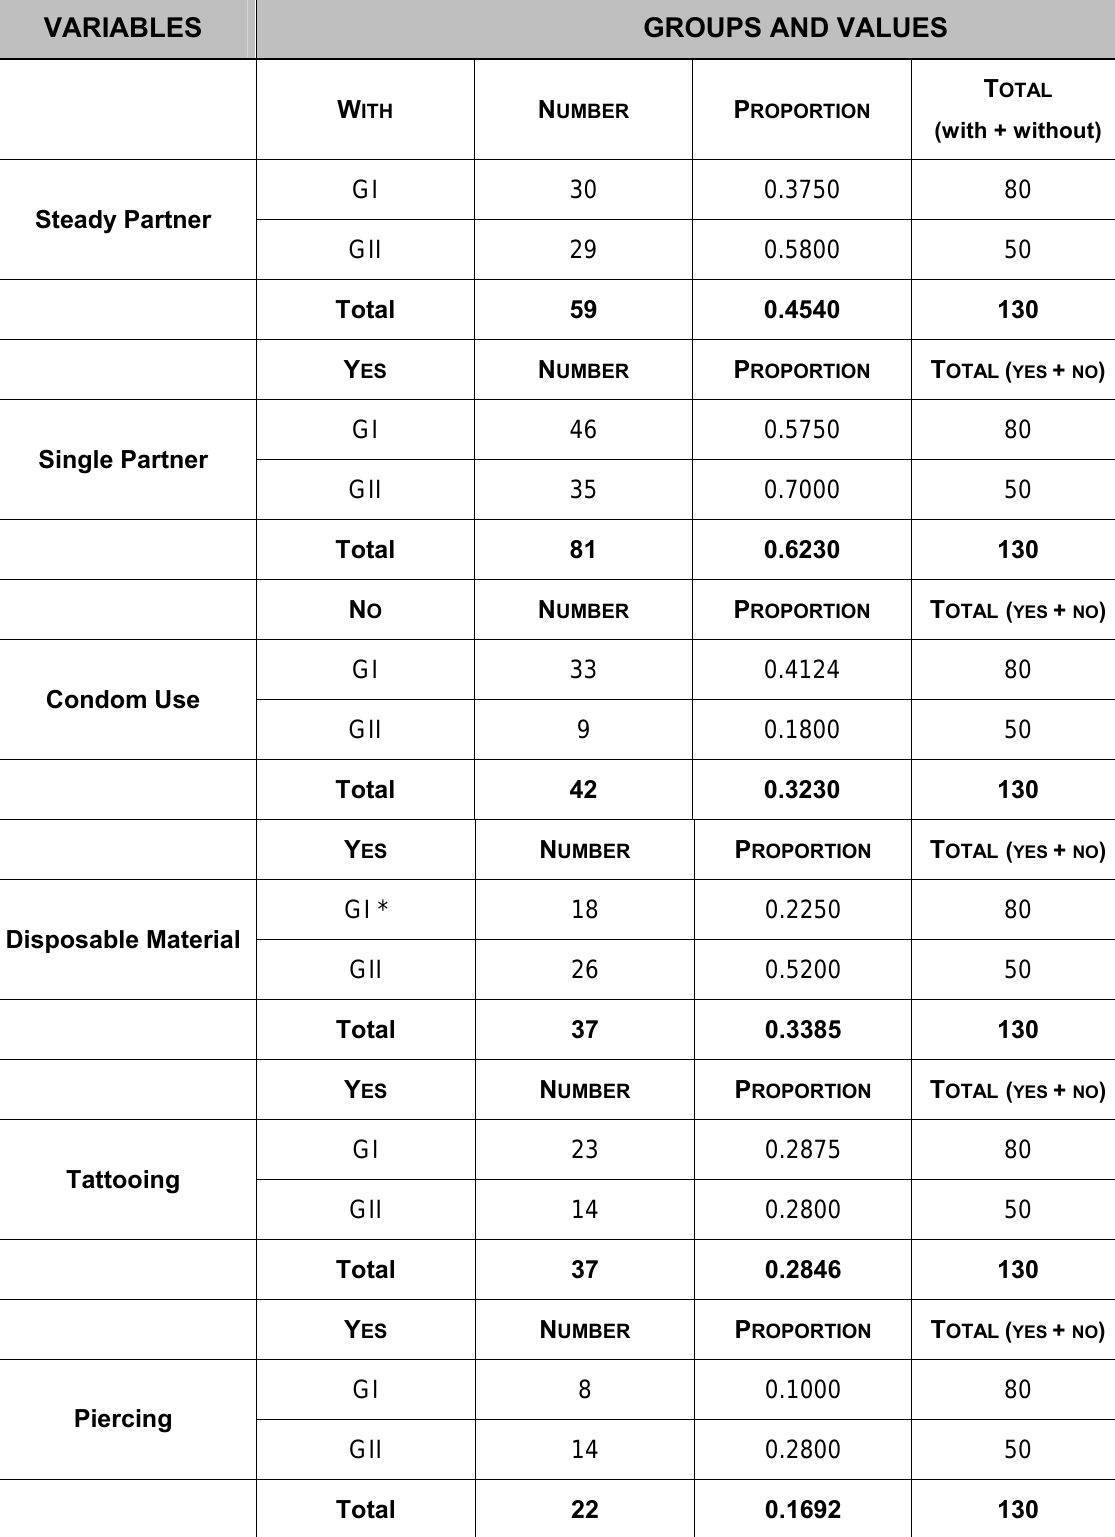
Table 3. Distribution of eighty individuals infected by C virus (GI) and fifty non-infected persons (GII) according to sexual behaviors – steady sexual partners (with or without) and single partner (yes or no) – as well as use of disposable materials, tattooing and piercing (yes or